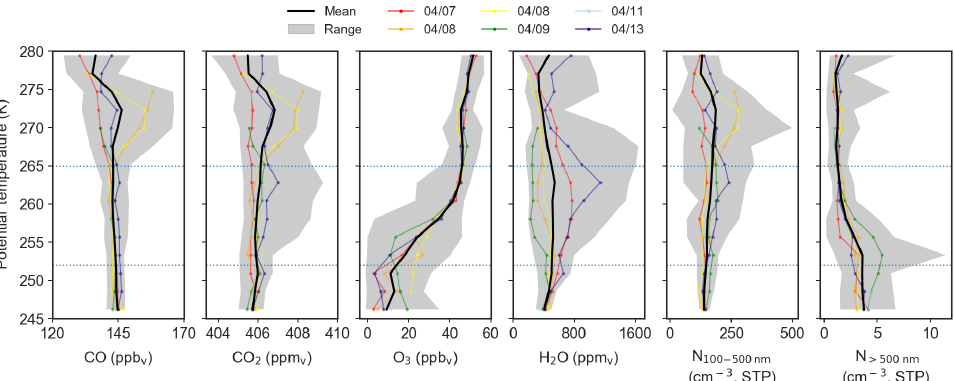
Figure 2. Mean potential temperature profiles of trace gases (CO, CO 2 , O 3 and H 2 O) and particle concentrations ( N 100–500 and N >500 ) in the polar dome observed during 7–13 April 2015. Coloured lines indicate the mean profile for each flight, the black line represents the mean profile over all flights, and gray shading shows the range of observations in each potential temperature bin. Horizontal dashed blue lines separate the lower, middle and upper polar dome defined as 245–252, 252–265 and